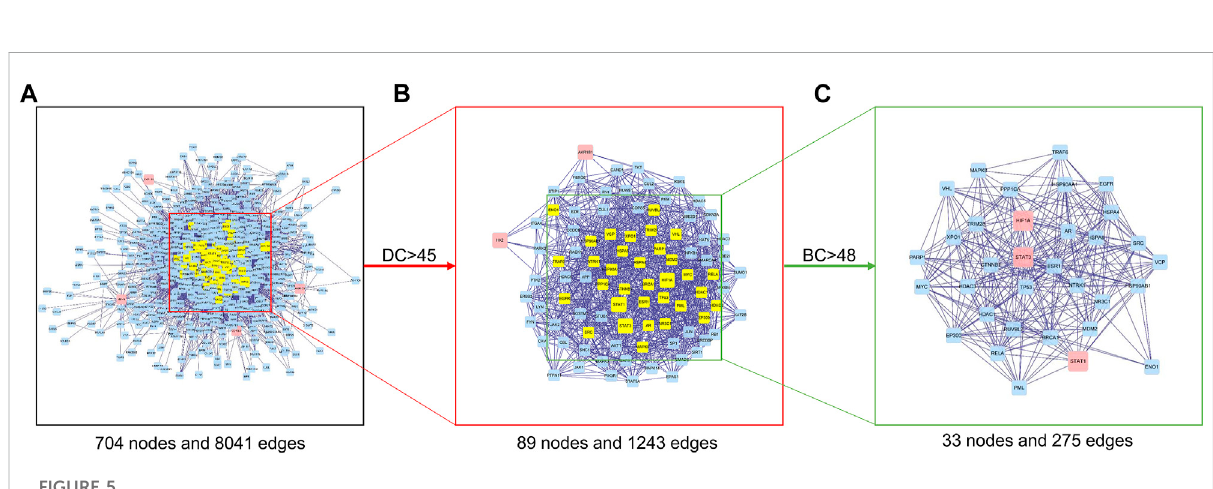
FIGURE 5 TopologicalanalysisofthePPInetwork. (A) InteractivePPInetworkofFFXST-relatedtargetsandIS-relatedtargets. (B) PPInetworkofsigni fi cant proteins extracted from (A) . (C) PPI network of candidate FFXST targets for IS treatment extracted from (B)